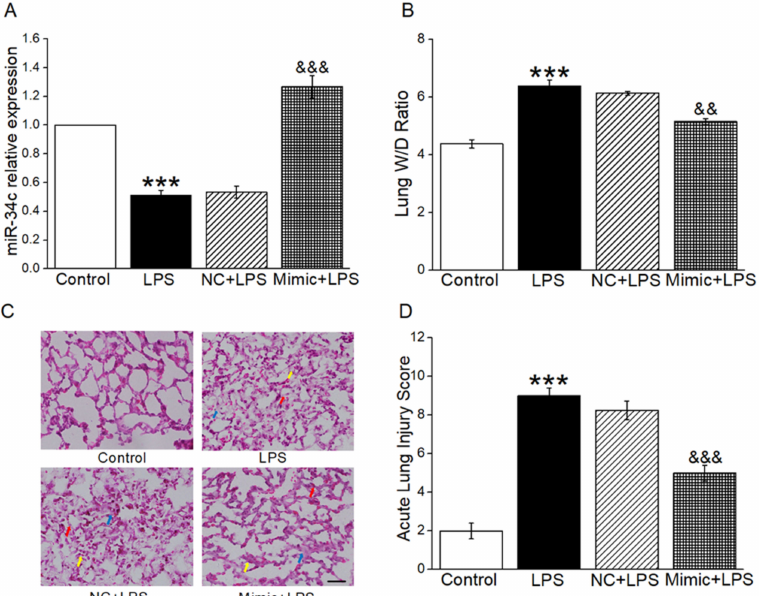
Figure 1. MiR-34c attenuated lung edema and histopathology changes in ALI mouse model. ( A ) The miR-34c level in mouse lung treated with miR-34c mimic by qRT-PCR assay. MiR-34c level in control (Control), LPS (LPS, 24 h, 5 mg/kg), miR-34c mimics negative control (NC, 72 h, 2 mg/kg) + LPS (24 h, 5 mg/kg) and miR-34c mimics (Mimic, 72 h, 2 mg/kg) + LPS (24 h, 5 mg/kg). The Relative level of miR-34c was calculated as miR-34c/U6 ratios ( n = 3–4). ( B ) The W/D ratio change in LPS-treated mice ( n = 4). ( C ) The effect of miR-34c on histopathology changes was assessed by HE staining ( × 400). Scale bar = 50 µ m. ( D ) Acute lung injury scores were recorded from 0 (no damage) to 16 (maximum damage). Note: *** p < 0.001, compared with Control group; && p < 0.01, &&& p < 0.001, compared with NC + LPS